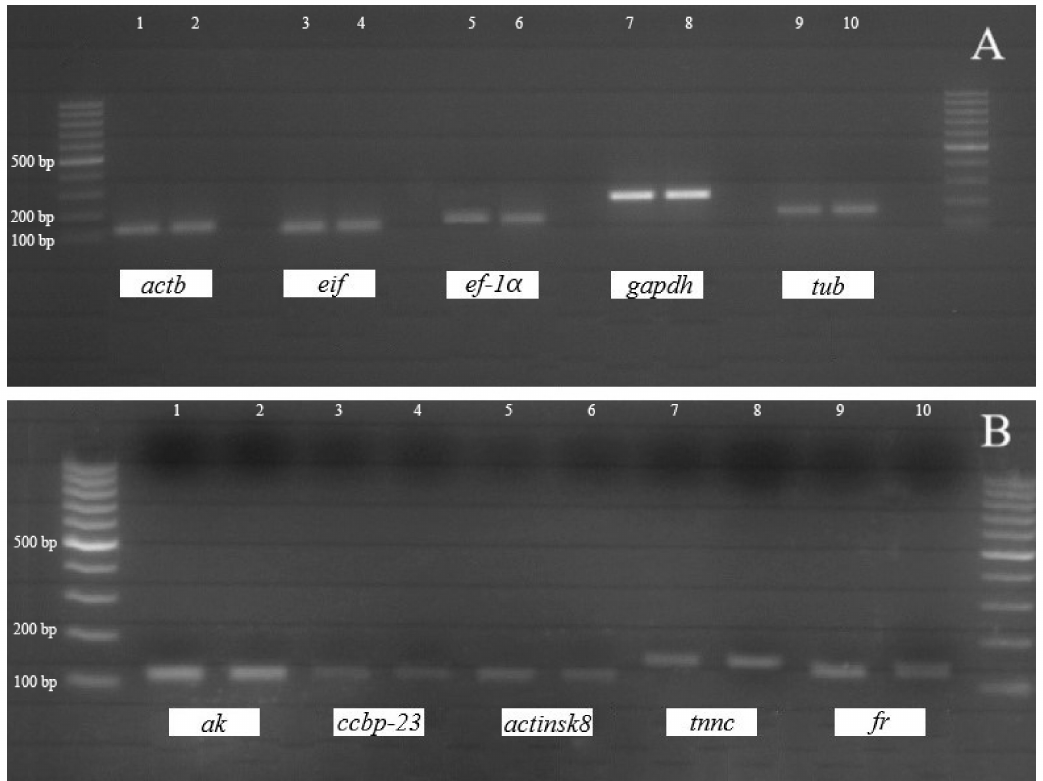
Figure 1. Electropherogram of the qPCR products of the five candidate reference ( A ) and target ( B ) genes in the muscle tissue of F. limosus . Abbreviations: actb , β -actin; gapdh , glyceraldehyde-3-phosphate dehydrogenase; eif , eukaryotic translation initiation factor 5a; ef-1 α , elongation factor-1 α ; tub , α -tubulin; tnnc , troponin c; ak , arginine kinase; fr , ferritin; ccbp-23 , crustacean calcium-binding protein 23; actinsk8 , skeletal muscle actin 8. Molecular weight 100–1000 bp.